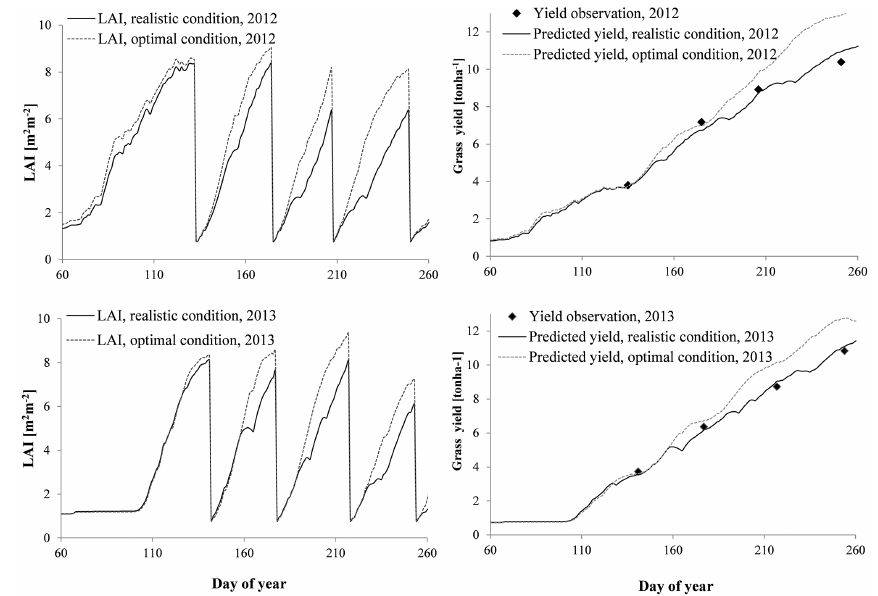
Figure 3. Predicted leaf area index, LAI and grass yield using the LINGRA-N model for 2012 and